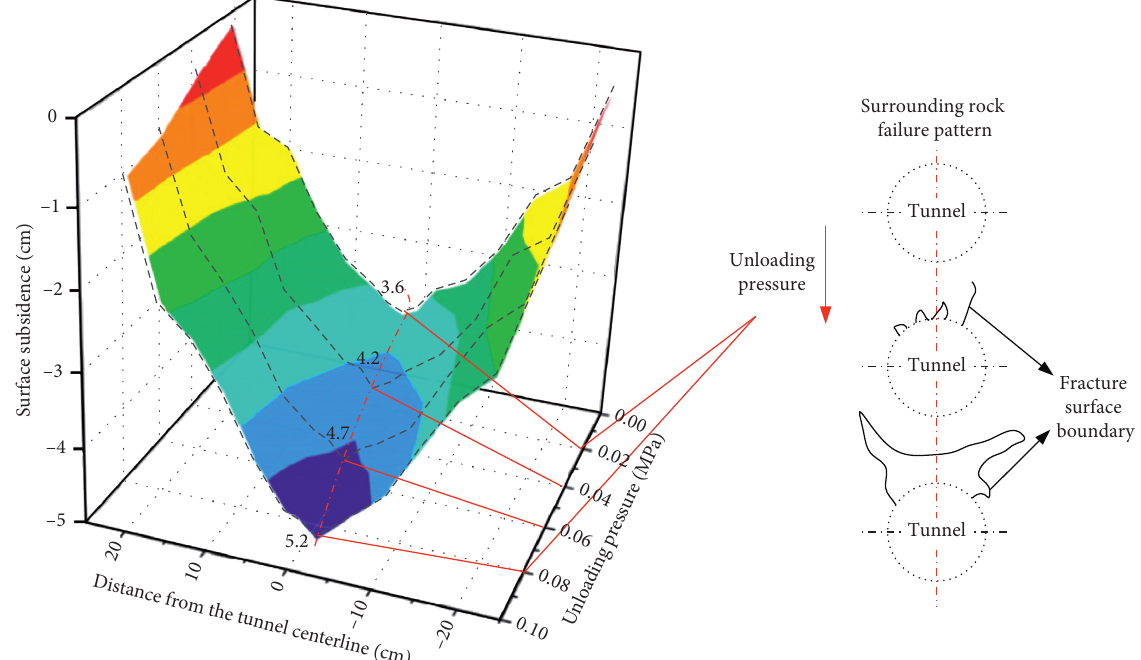
Figure 13: Settlement curve groove and failure pattern of surrounding rock in working condition